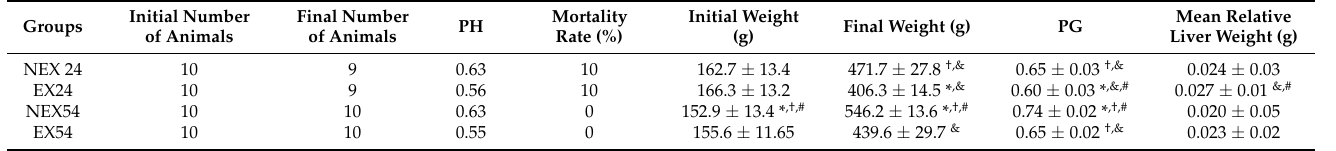
Table 1. Number of animals, ponderal homogeneity index (PH), mortality rate, initial and final animal body weights (g), ponderal gain (PG) and mean relative liver weight for all experimental